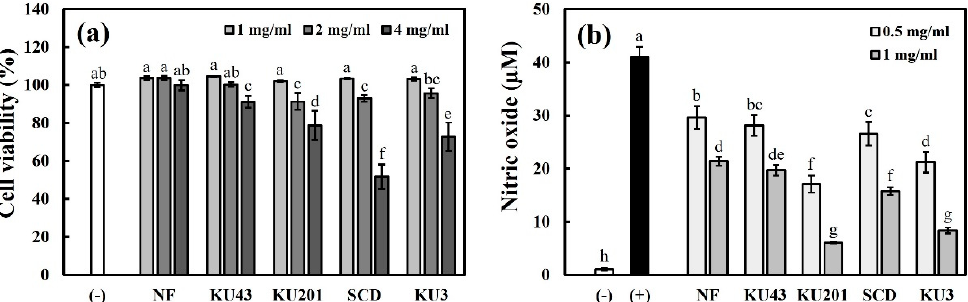
Figure 2. Cell viability and nitric oxide (NO) production in RAW 264.7 cells: ( a ) cell viability; ( b ) production of cellular NO. ( − ): negative control without lipopolysaccharide (LPS); (+): positive control with LPS; NF: nonfermented hydroponic ginseng (HG); KU43: HG fermented with B. subtilis KU43; KU201: HG fermented with B. subtilis KU201; SCD: HG fermented with B. polyfermenticus SCD; KU3: HG fermented with B. polyfermenticus KU3. The data are represented as means ± standard deviations of triplicates. Statistical differences ( p < 0.05) are represented with different letters above error bars.